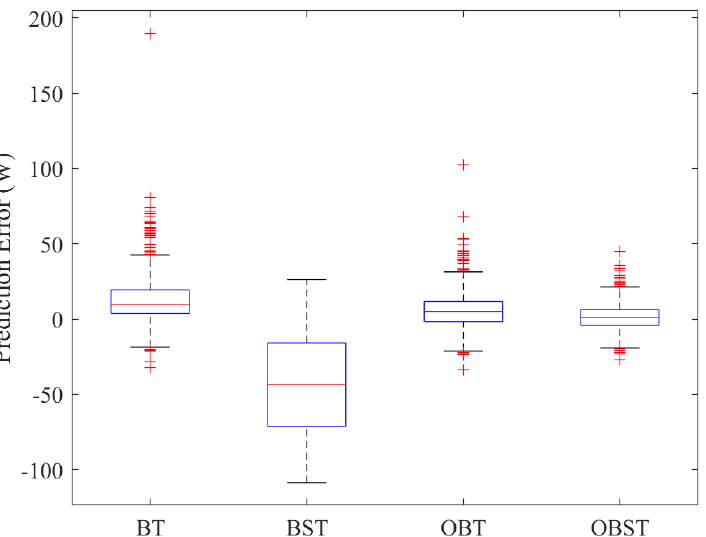
Figure 8. Boxplot of residual errors of bagged tree, boosted tree, optimized BG, and optimized BS